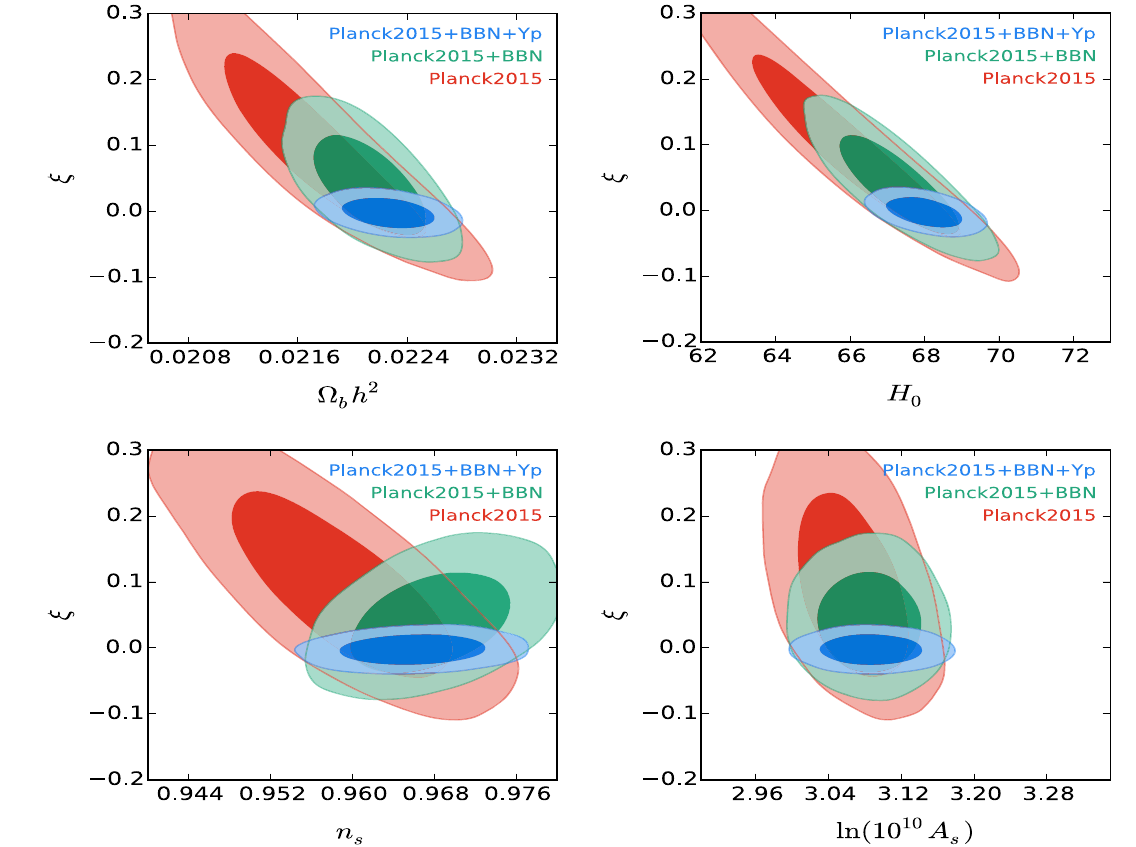
Fig. 4 Marginalized two-dimensional contours in ξ − (cid:9) b h 2 ( top-left ), BBN consistency, derived from the data of Planck 2015 + JLA + BAO ξ − H ξ − n ξ − A ( green ) and Planck 2015 + JLA + BAO + Y p ( blue ). The red contours s ( bottom-left ) and s ( bottom-right ), 0 ( top-right ), with 68 and 95% confidence level in the extended (cid:19) CDM model with correspond to Y p = 0 . 24, derived from Planck 2015 + JLA +